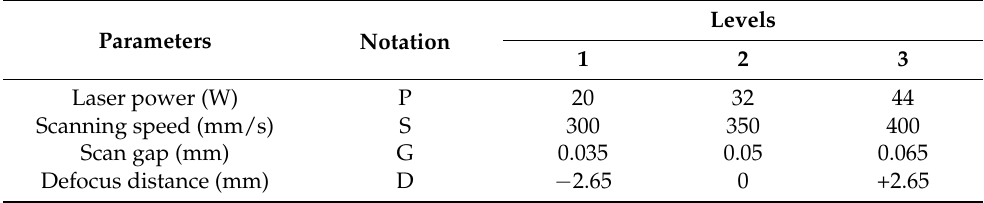
Table 1. Laser Engraving